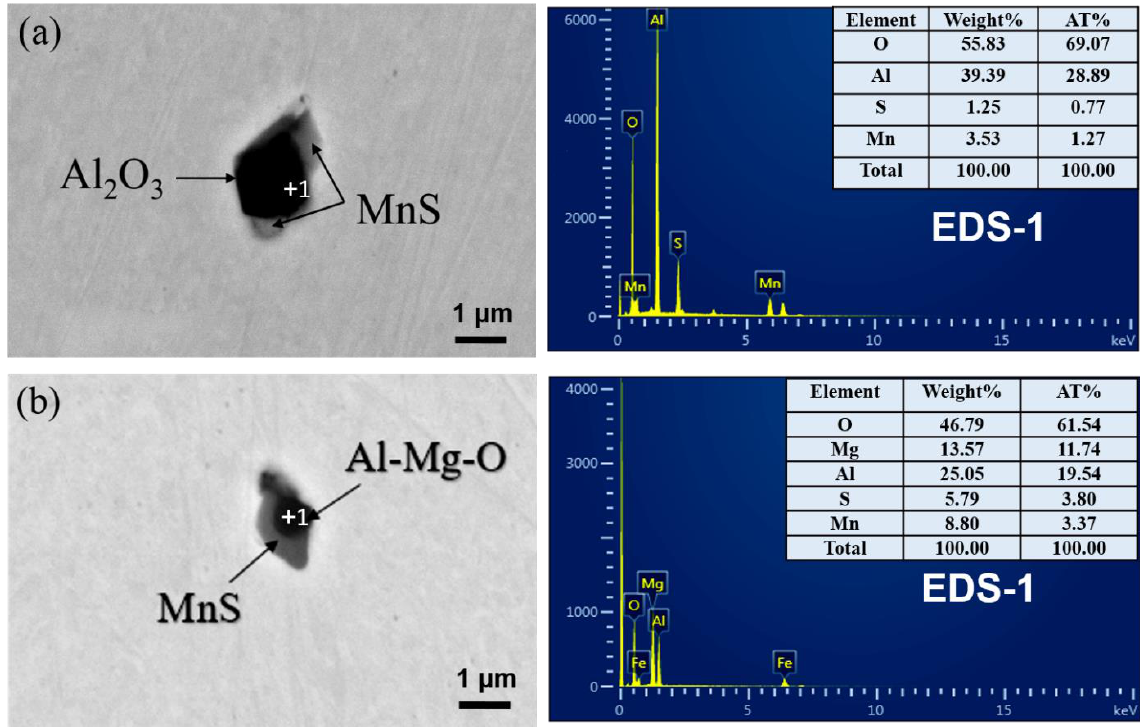
Figure 5. Morphology and composition of inclusions in HAZ of ( a ) benchmark steel and ( b ) Mg-treated steel.